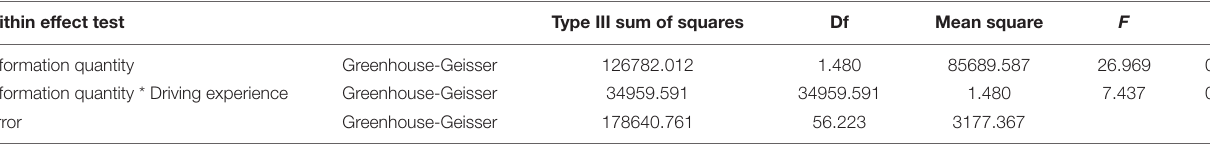
TABLE 7 | The information amount factor main effect and interaction effect of the experience factor.